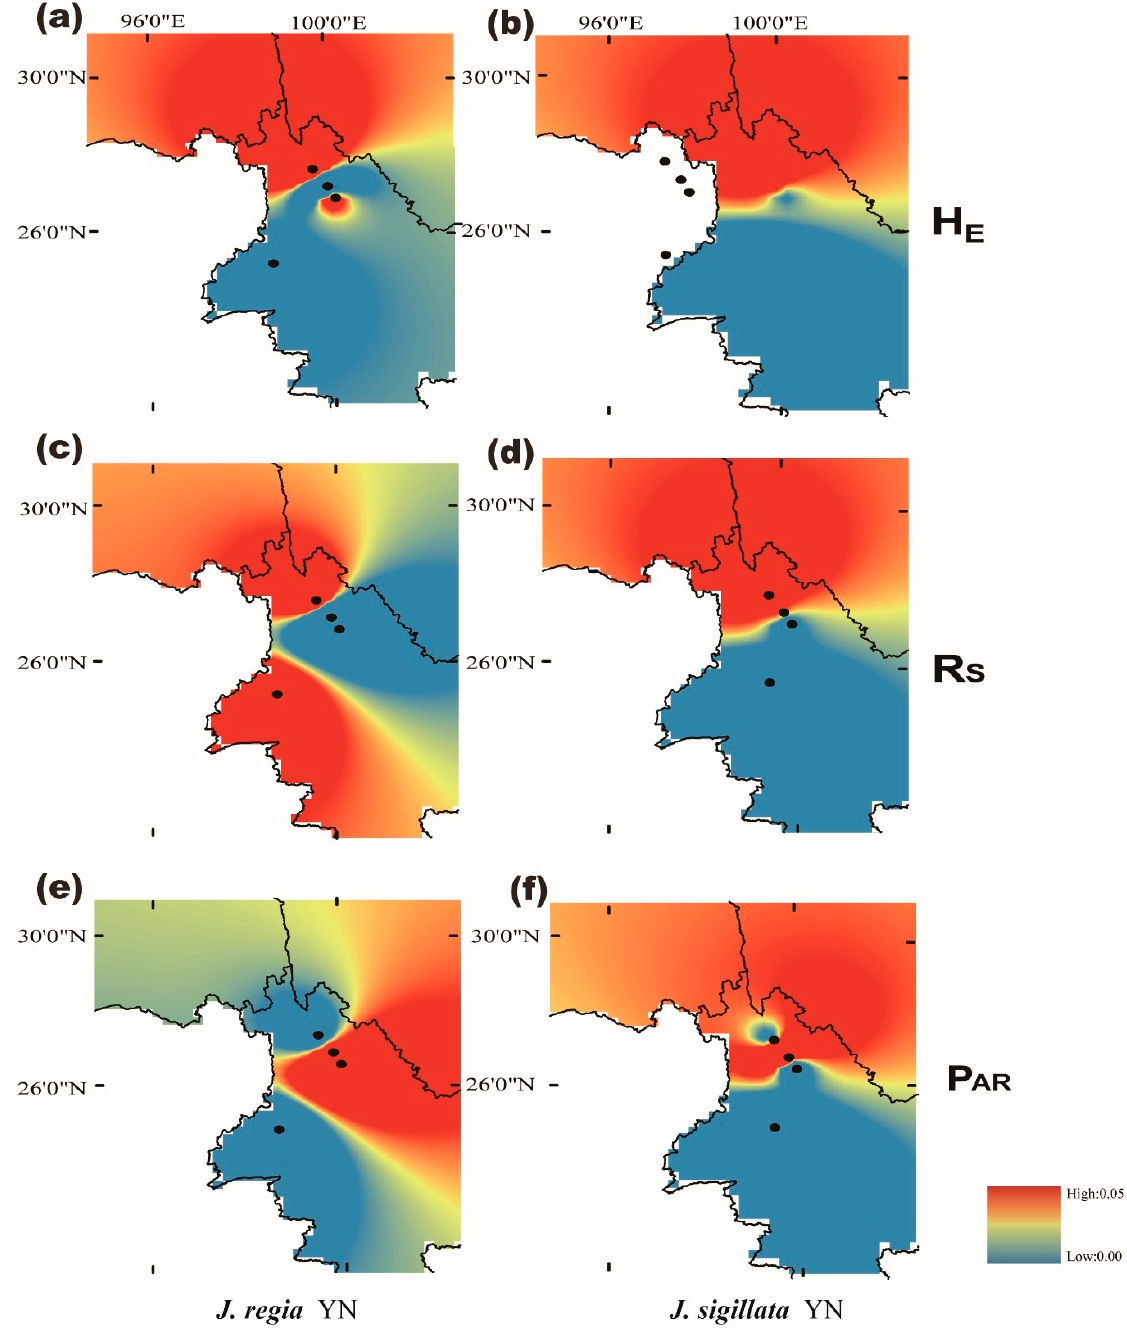
Figure 3. IDW interpolation of the expected heterozygosity ( He ), the allelic richness ( Rs ), and the private allele richness ( P AR ) for the eight populations (black dots; four pairs of the sympatric J. regia and J. sigillata populations) from Yunnan province using 17 EST-SSR markers. The numbers of walnut populations are shown in Table 1. IDW interpolation of ( a , c , e ) expected heterozygosity ( He ), allelic richness ( Rs ), and private allele richness ( P AR ) values of J. regia ; ( b , d , f ) expected heterozygosity ( He ), allelic richness ( Rs ), and private allele richness ( P AR ) values of J. sigillata .